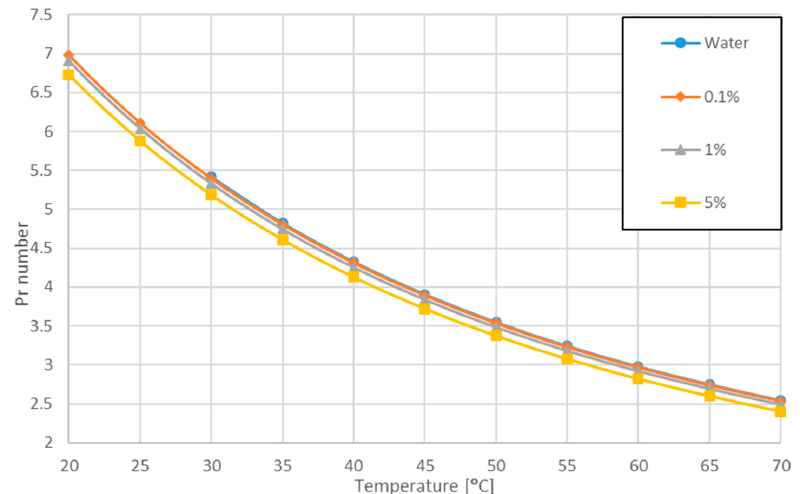
Figure 13. Prandtl number for water-Al 2 O 3 nanofluids.